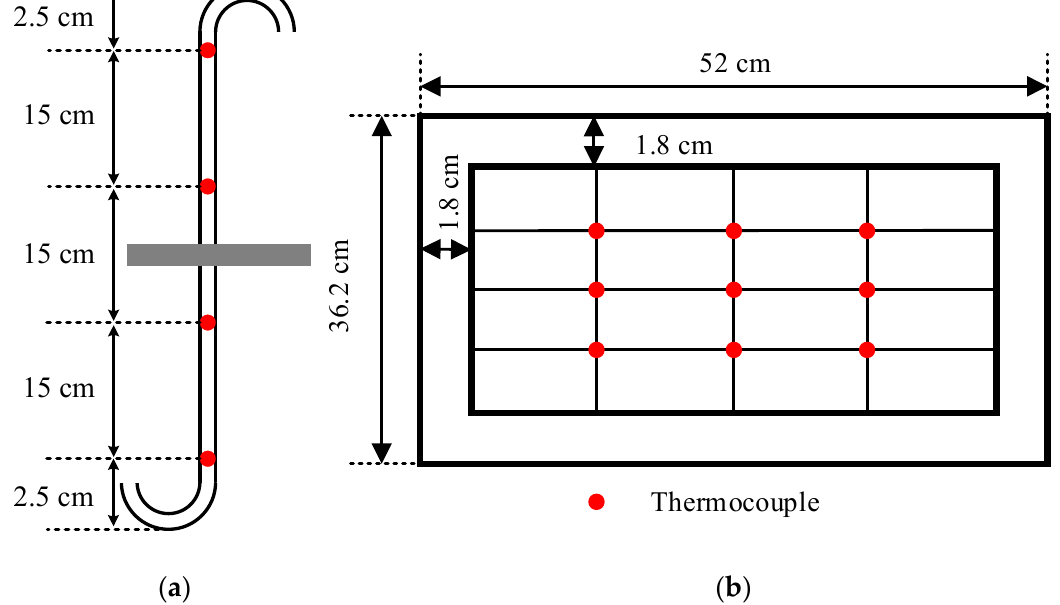
Figure 3. ( a ) Thermocouples’ positions on the tube on evaporator and condenser sides; ( b ) thermocouple positions at the inlet and outlet of the cooling air duct.